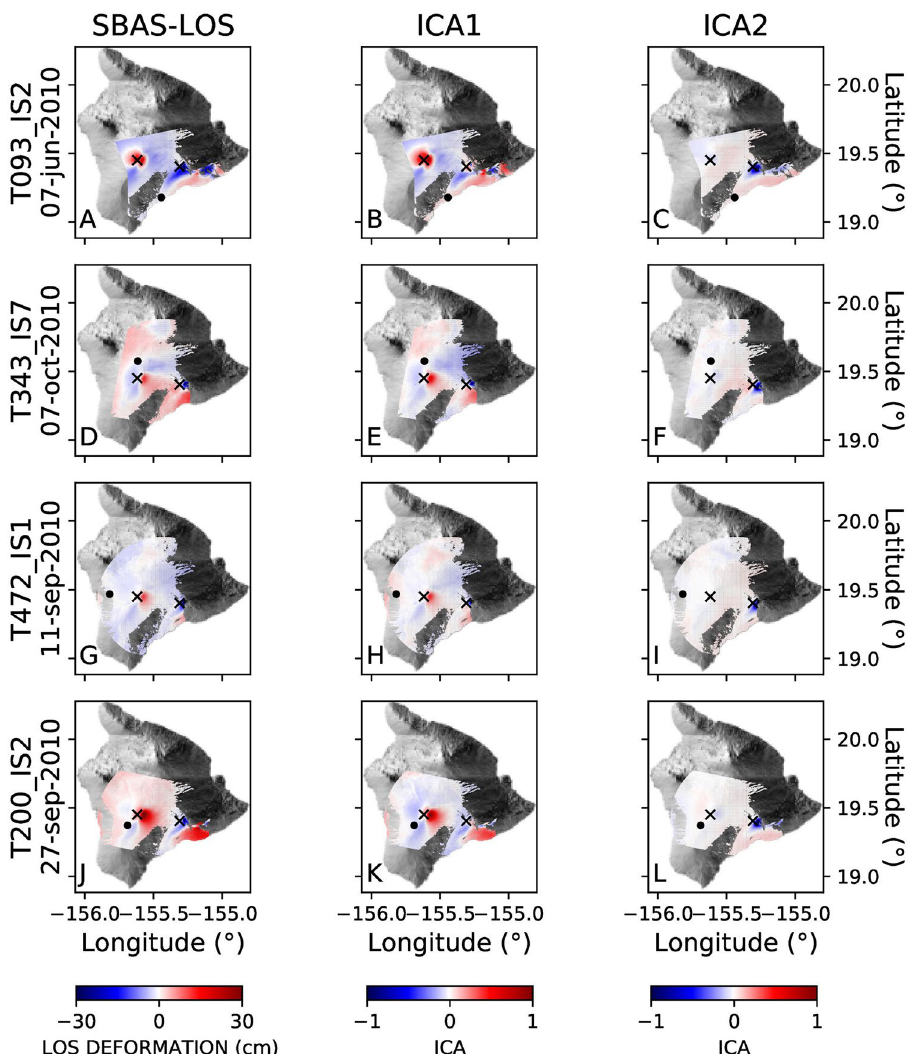
Figure 2. LOS deformation cumulative maps. ( A ), ( B ), ( C ): ENVISAT 093 orbit; ( D ), ( E ), ( F ): ENVISAT 343 orbit; ( G ), ( H ), ( I ) : ENVISAT 472 orbit; ( J ), ( K ), ( L ): ENVISAT 200 orbit (see Table S2 for track details). Column 1 shows the LOS cumulative displacement DInSAR map; columns 2 and 3 represent the first and second components resulting from applying the ICA decomposition algorithm. The black crosses indicate the points used for extracting the time series shown in Fig. 3, while black dots are the reference points used for the DInSAR SBAS